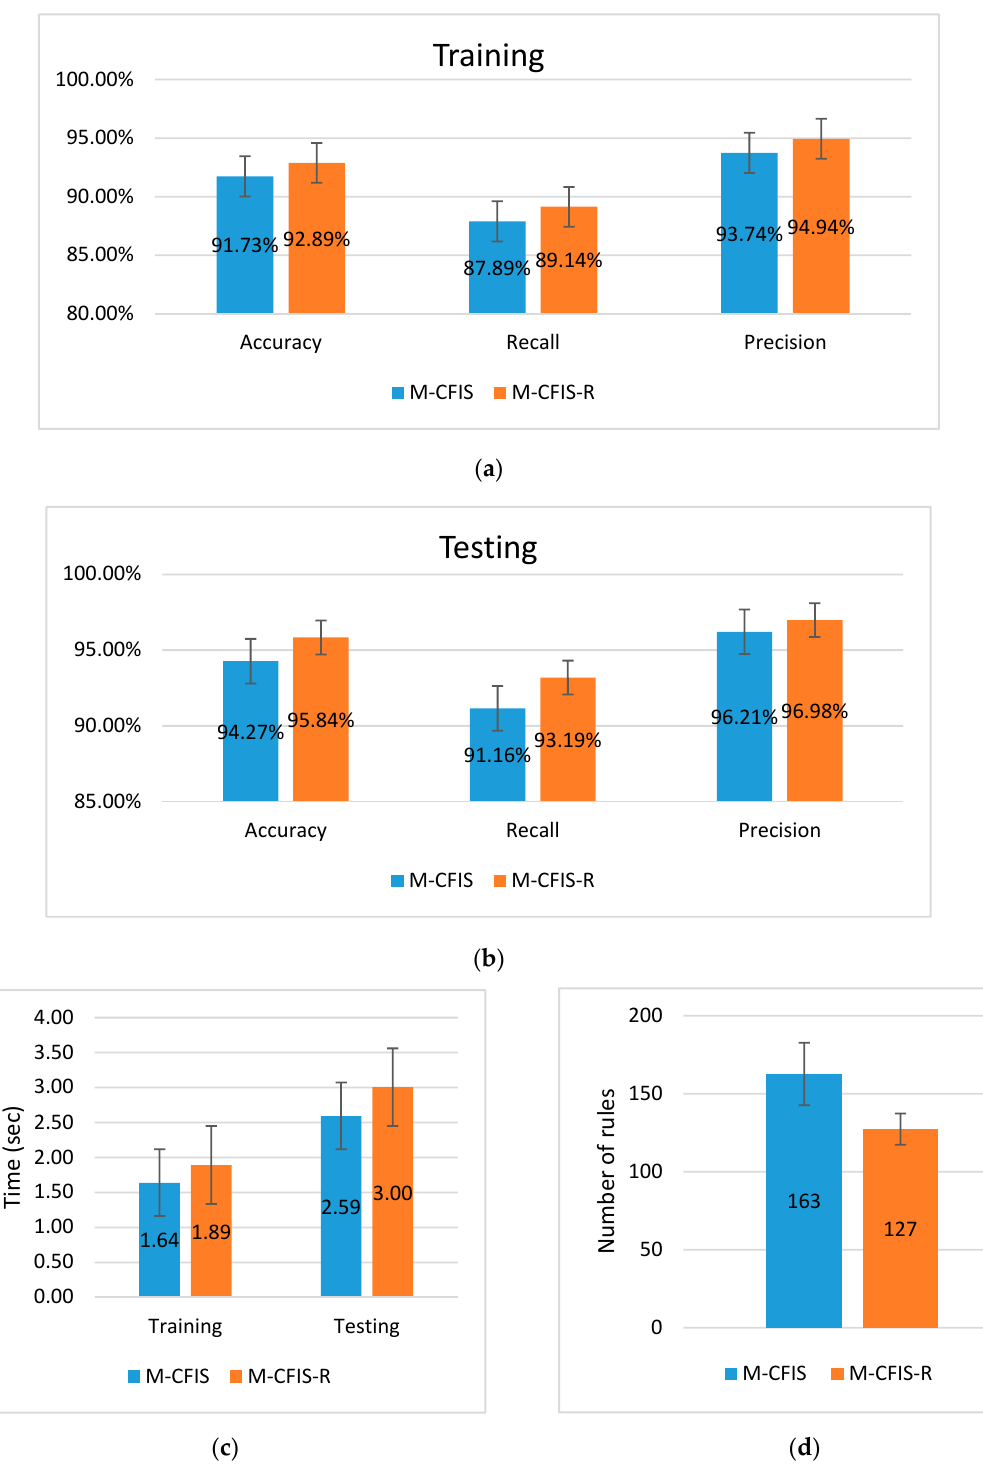
Figure 4. Performance on the WBCD dataset: ( a ) Accuracy, Recall, and Precision on training set; ( b ) Accuracy, Recall, and Precision on testing set; ( c ) Time consumed; ( d ) Number of rules.